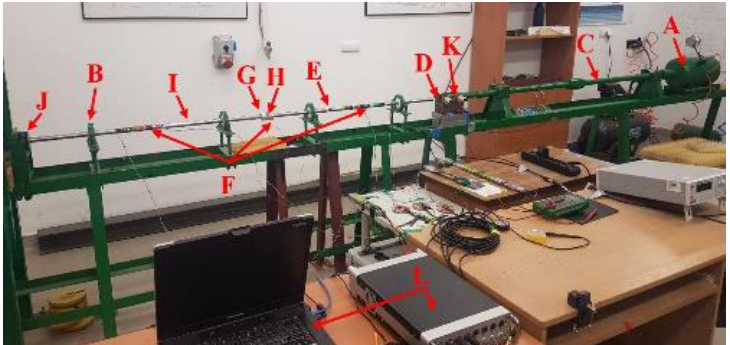
Figure 2. Real view of the SHPB stand at Department of Military Engineering and Infrastructure, MUT (reprinted from Ref. [70]).